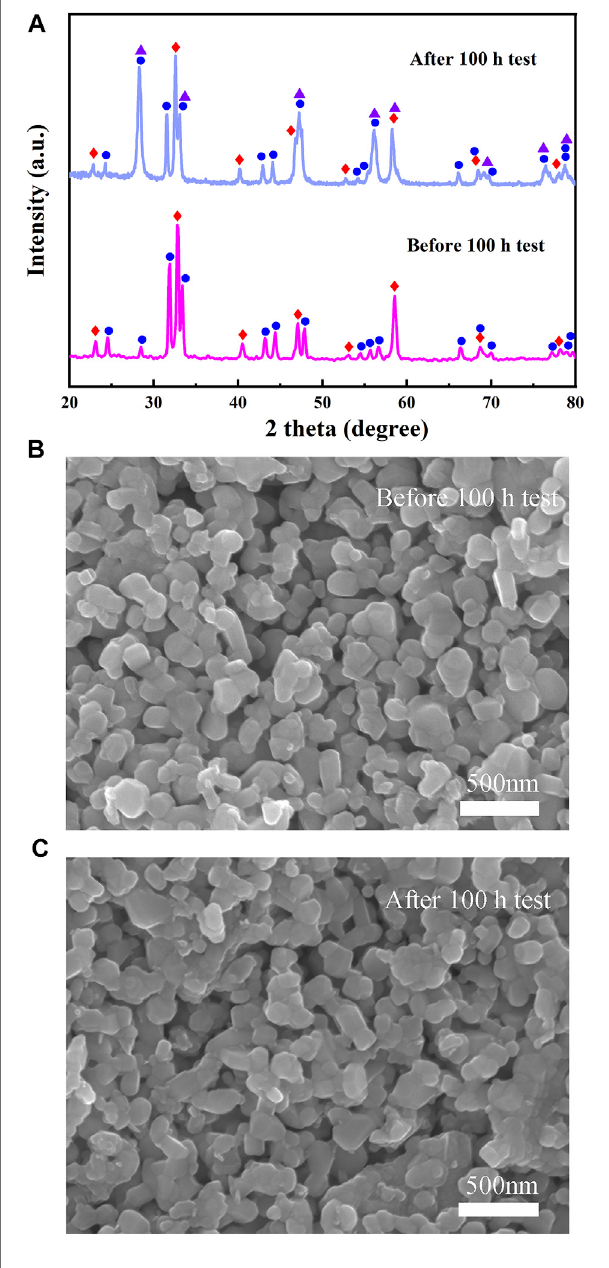
with mass ratios of PSFN 113 and PSFN 214 of 1:0, 0:1, 6:4, 5:5, and 4:6. At 500 – 800 ° C, the EIS test is performed on three symmetrical batteries at intervals of 50 ° C, as shown in Figures 6A – E . The cathodic polarization resistance (Rp) is the difference between the real axis intercepts of the impedance diagram (Li et al., 2017), and the corresponding values are shown in Table 2 . Within the above temperature range, the R P of the three materials all followed the following sequence: PSFN 113-214 (5:5) < PSFN 113-214 (4:6)